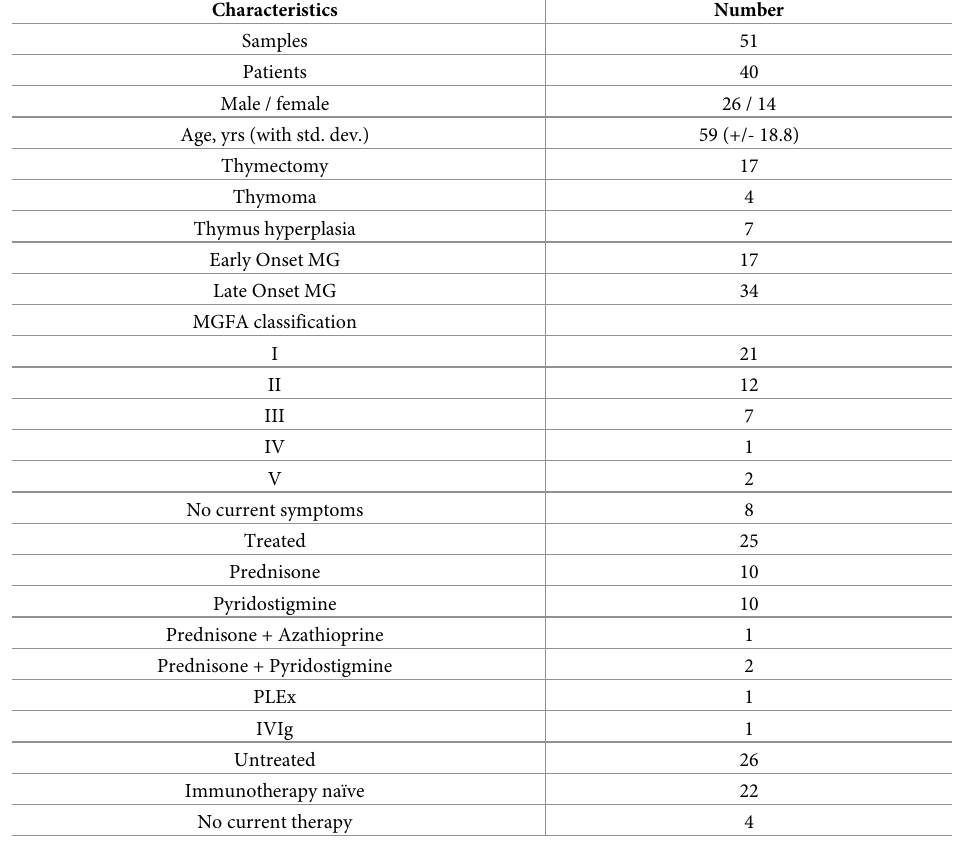
Table 1. Clinical characteristics and demographics of MG